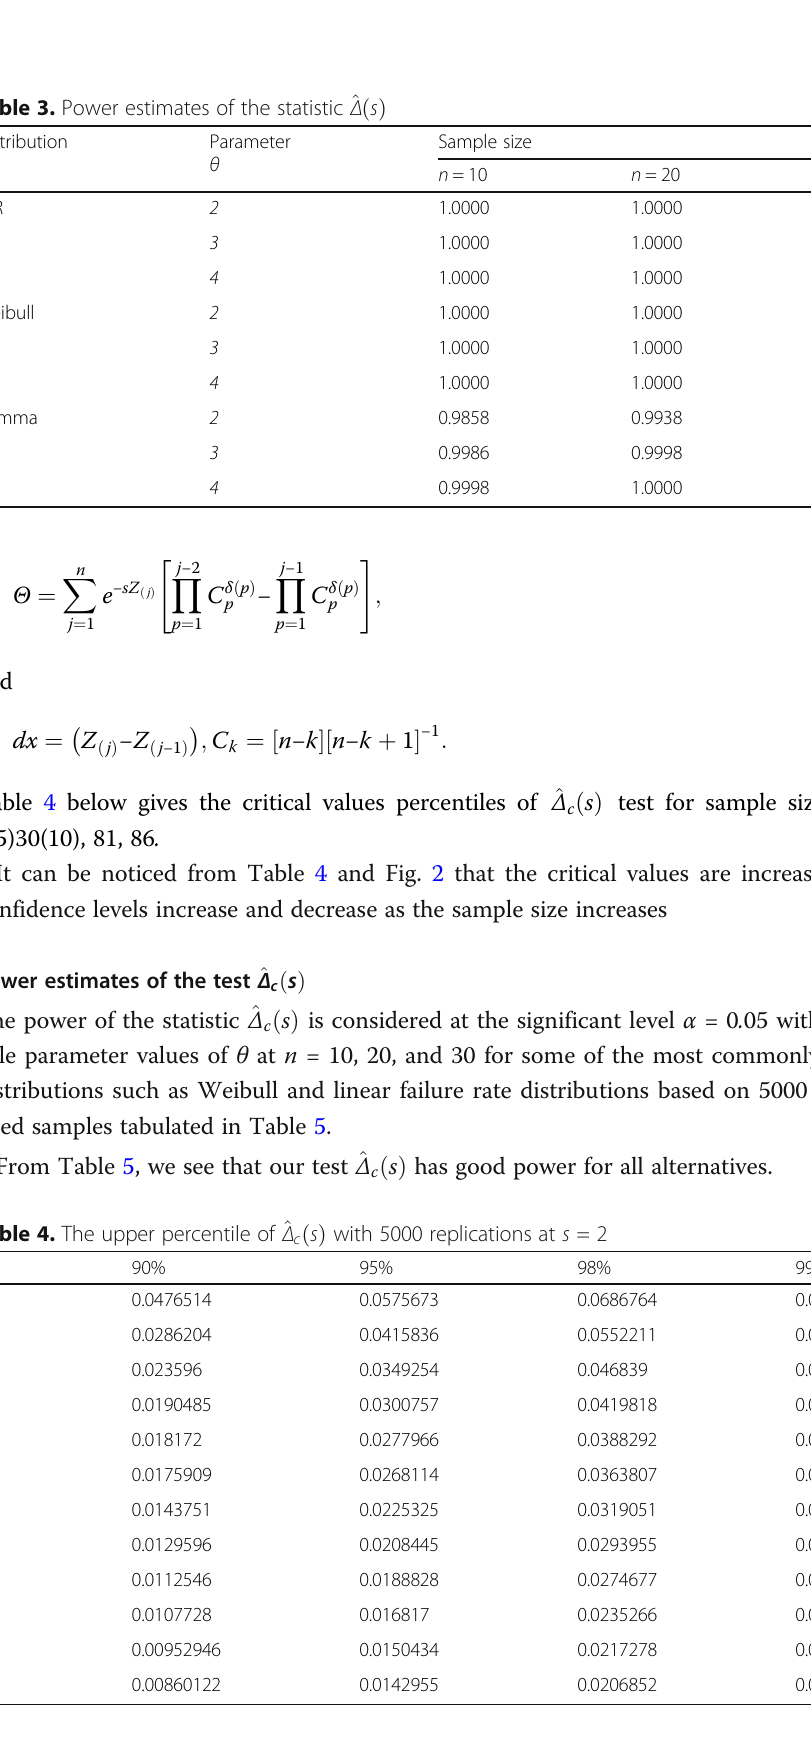
Table 3. Power estimates of the statistic ^ Δ ð s Þ Distribution Parameter θ